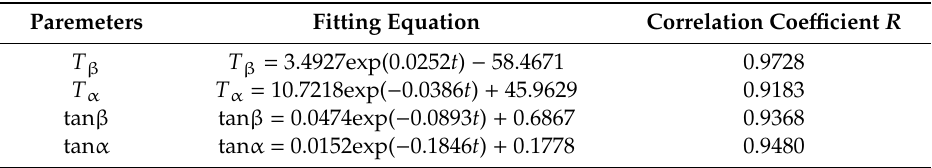
Table 2. Fitting results of loss factor parameters with aging